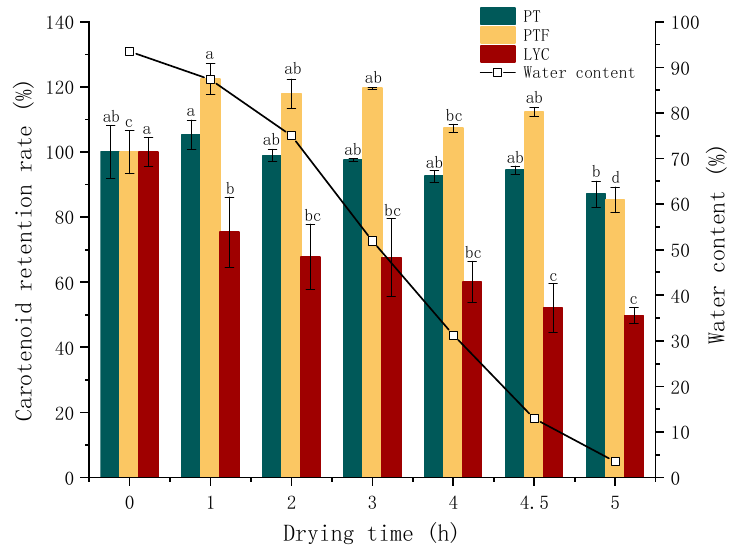
Figure 4. The change in retention rate and moisture content in hot-air drying (HAD). The raw material was the mixed tomato pulp of five tomato varieties selected. The retention rate was obtained by comparing tomato powder or puree after drying treatment with tomato pulp material. Different letters between columns of the same color are significant ( p < 0.05), according to Duncan test.